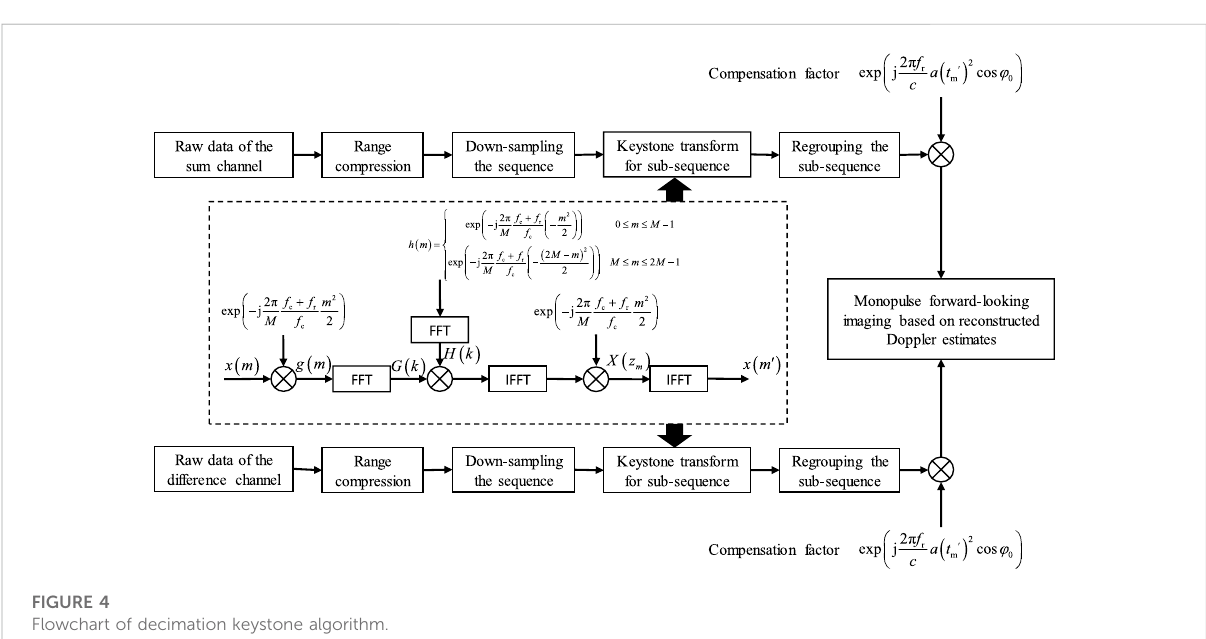
FIGURE 4 Flowchart of decimation keystone